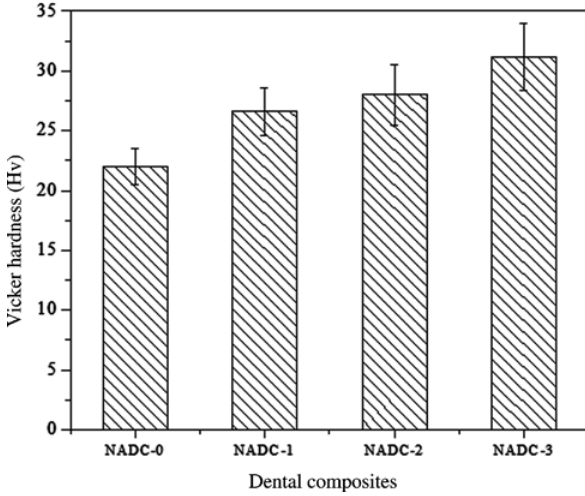
Figure 2: Effect of Vickers hardness of silane treated nanoalumina filled dental